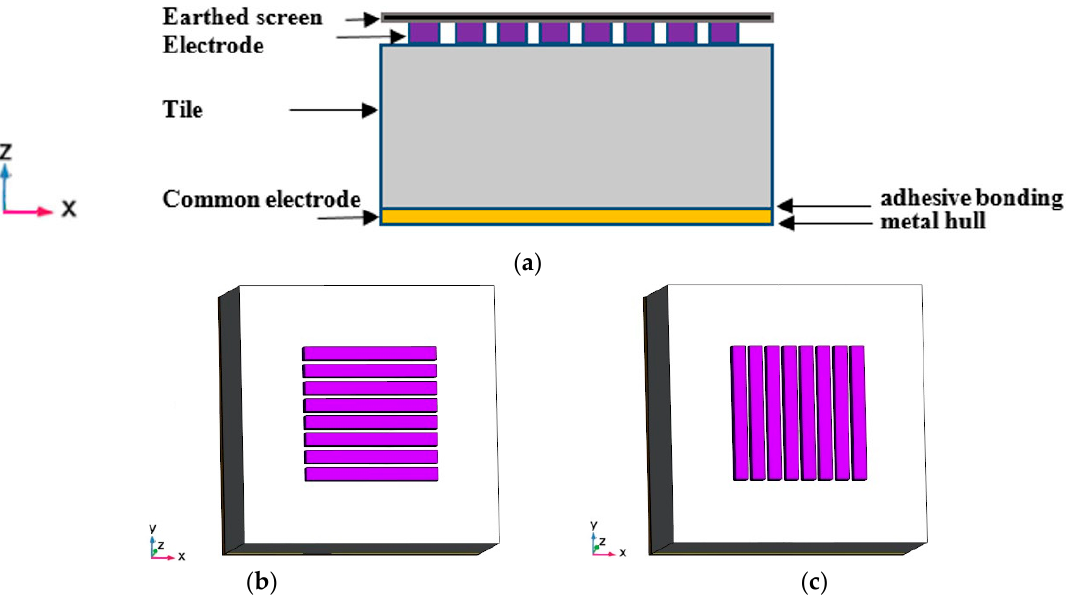
Figure 1. Principle of proposed capacitance sensor array. ( a ) Front view, ( b ) top view of horizontally placed capacitance array, ( c ) top view of vertically placed capacitance array.